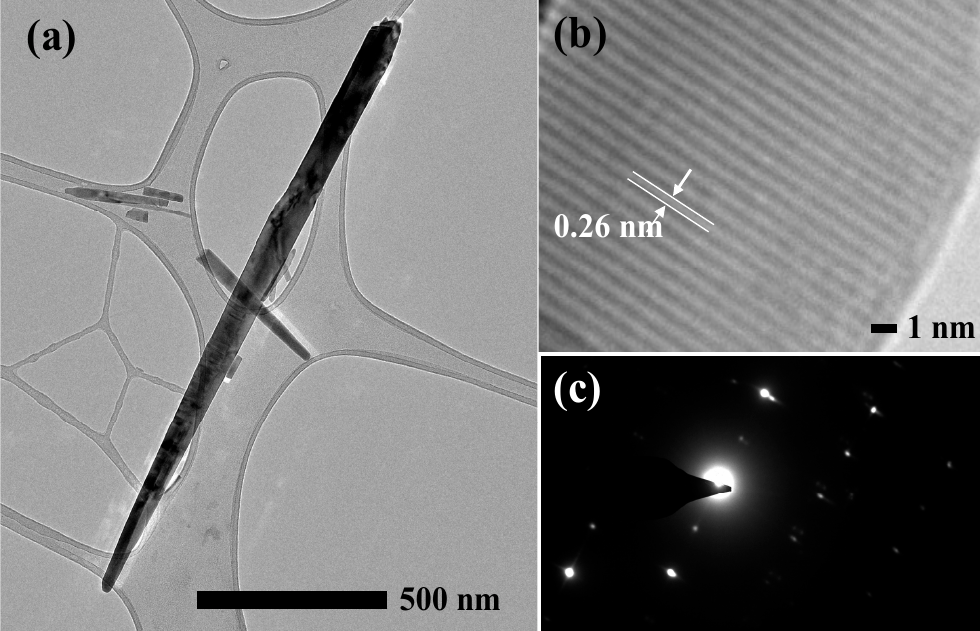
Figure 4. Transmission electron microscopy (TEM) images of ZnO NRs synthesized for 2 h at ( a ) low magnification TEM image, ( b ) high magnification TEM image, and ( c ) the selected area of electron diffraction (SAED) pattern, obtained at 120 kV.